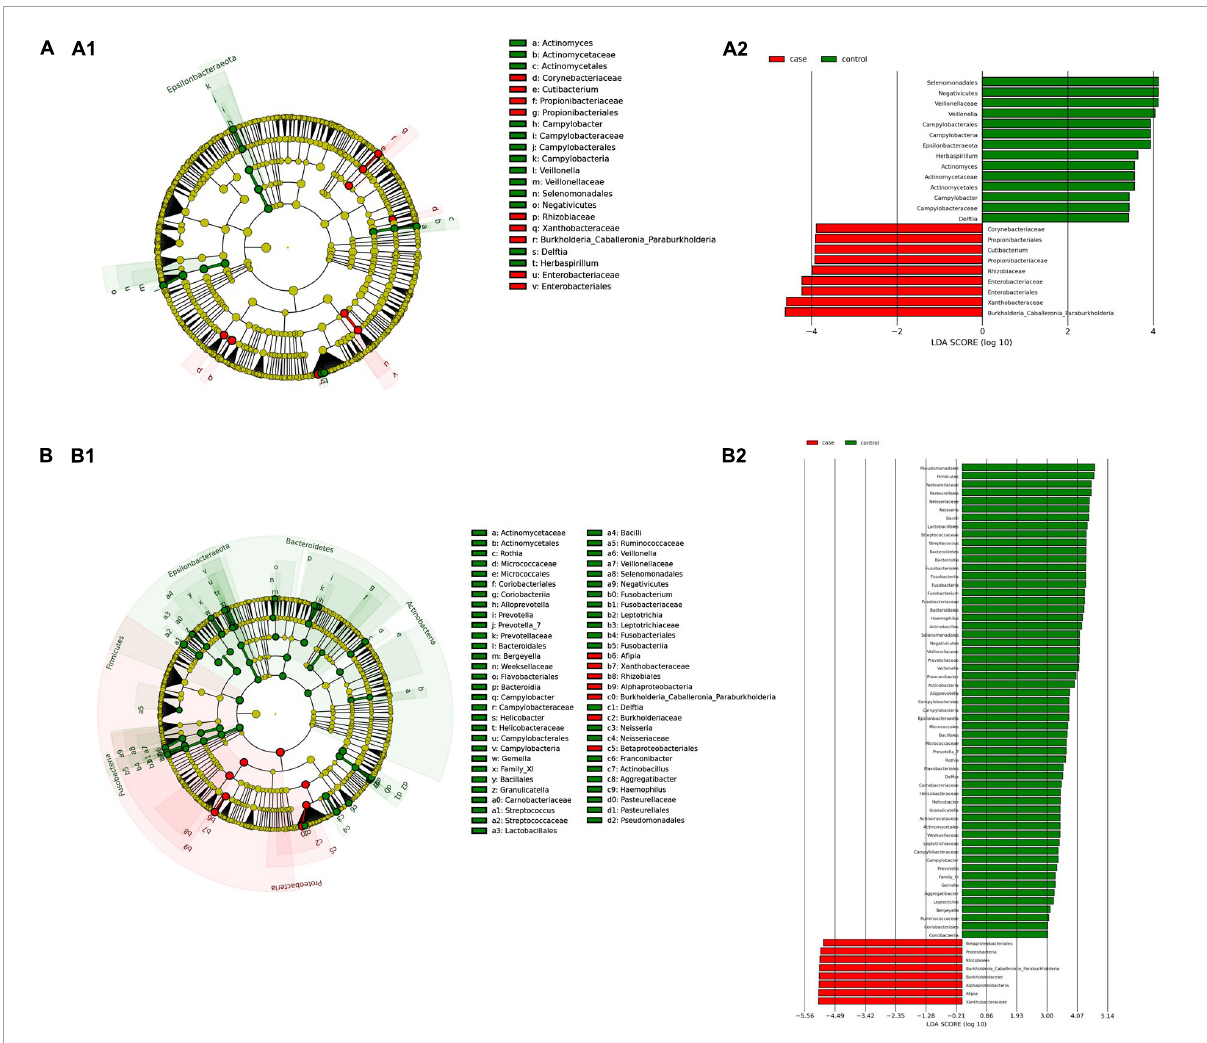
FIGURE3 Linear discriminant analysis (LDA) integrated with effect size (LEfSe). Cladogram representing the differentially abundant taxonomic groups in the microbiota from the duodenum of CeD following an unrestricted diet (A1) or a GFD (B1) . Graph bar representing the microbial biomarkers found in the microbiota from the duodenum of CeD following an unrestricted diet (A2) or Patients with CeD following a GFD (B2) (LDA score > 3, p < 0.001). Control: Control group, represented in green. Case: Patients with CeD, represented in